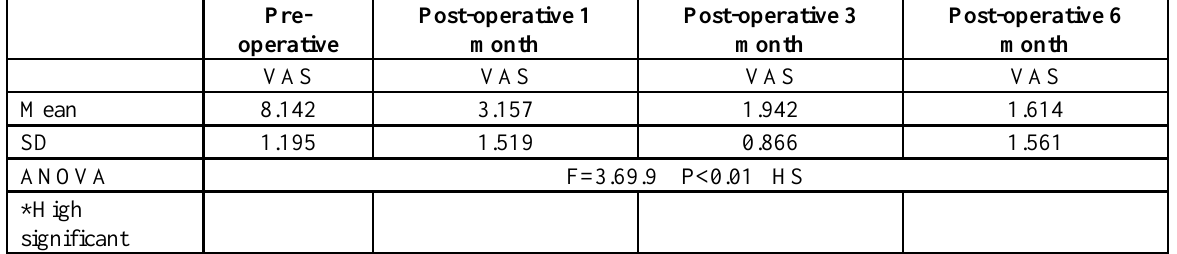
Table 1: VAS Results